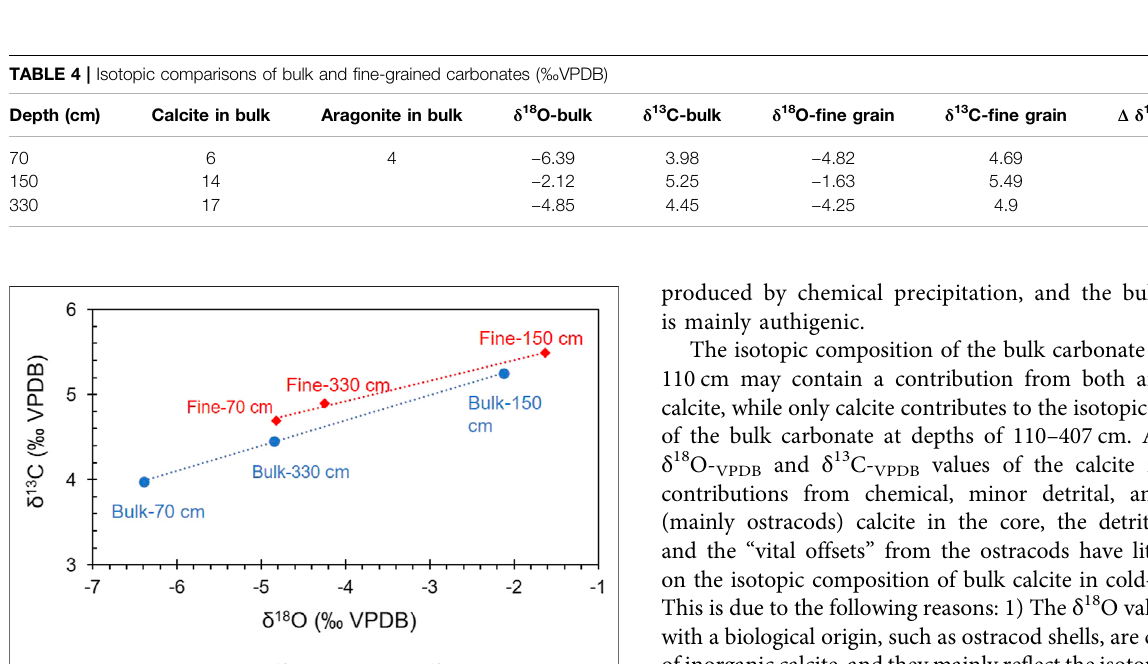
Frontiers in Earth Science |